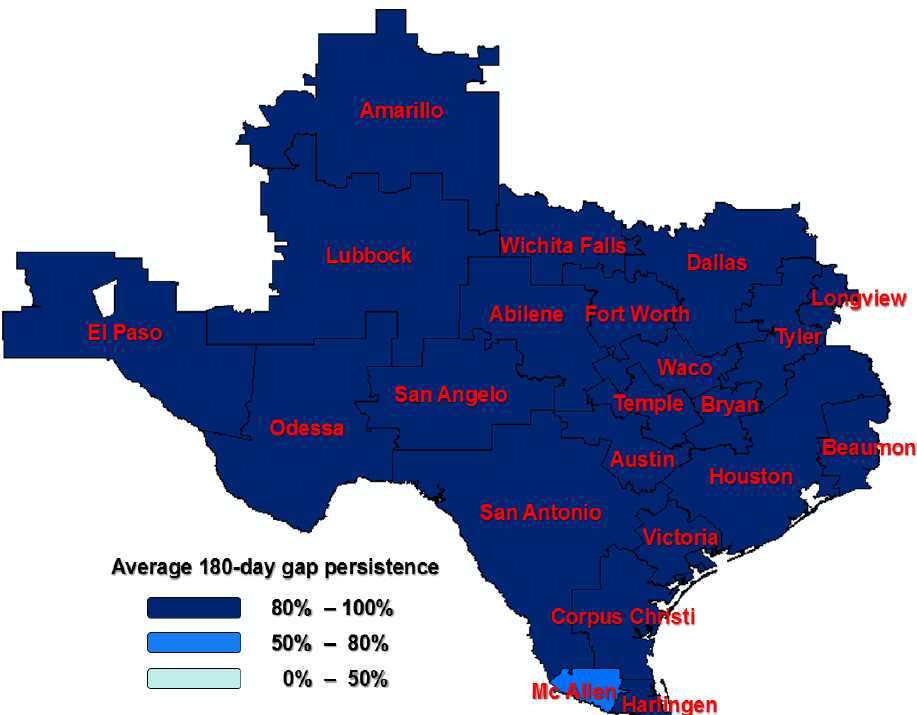
Figure A2. A 60-day persistence among Texas Hospital Referral Regions (HRRs); HRRs outside of Texas were not considered in the study.